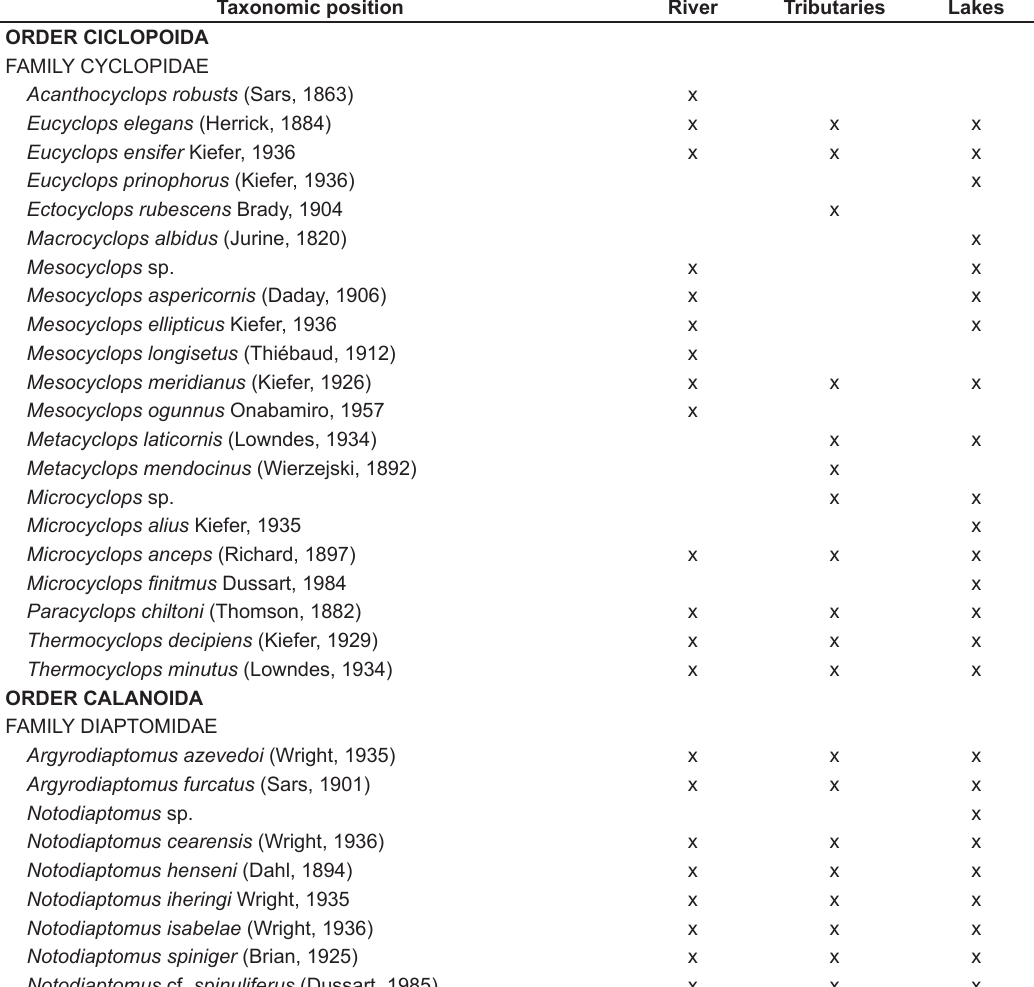
Table 2. Species list and spatial occurrence of copepods collected in this study in the Upper Paraná River floodplain. Taxonomic